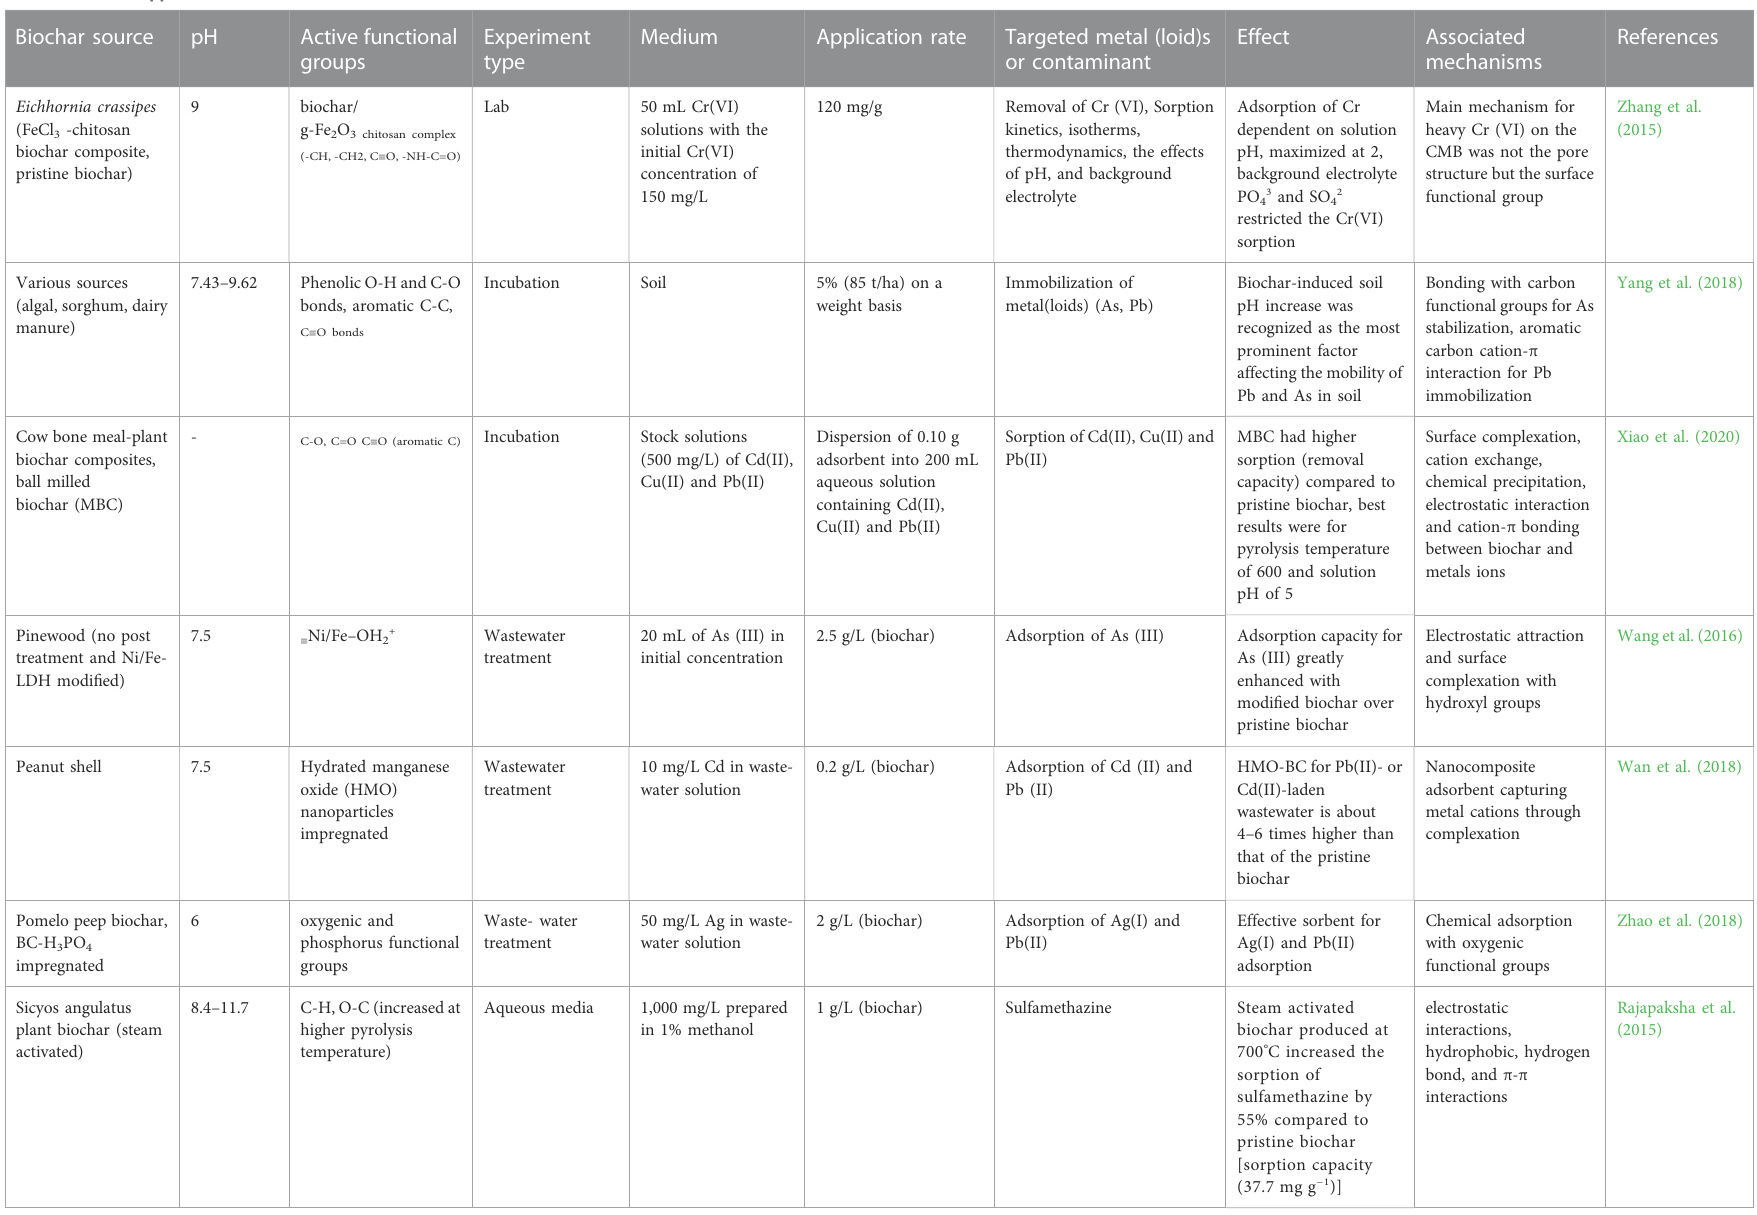
TABLE 2 Biochar application in soil and water remediation for metal(loids) and other